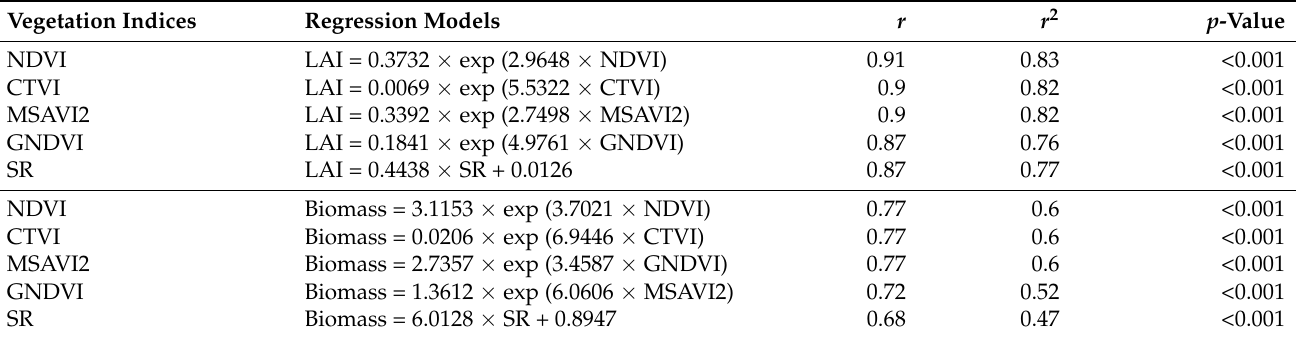
Table 3. Regression between sorghum LAI and shoot biomass values and vegetation indices using data in 2018 field trial (n = 390).